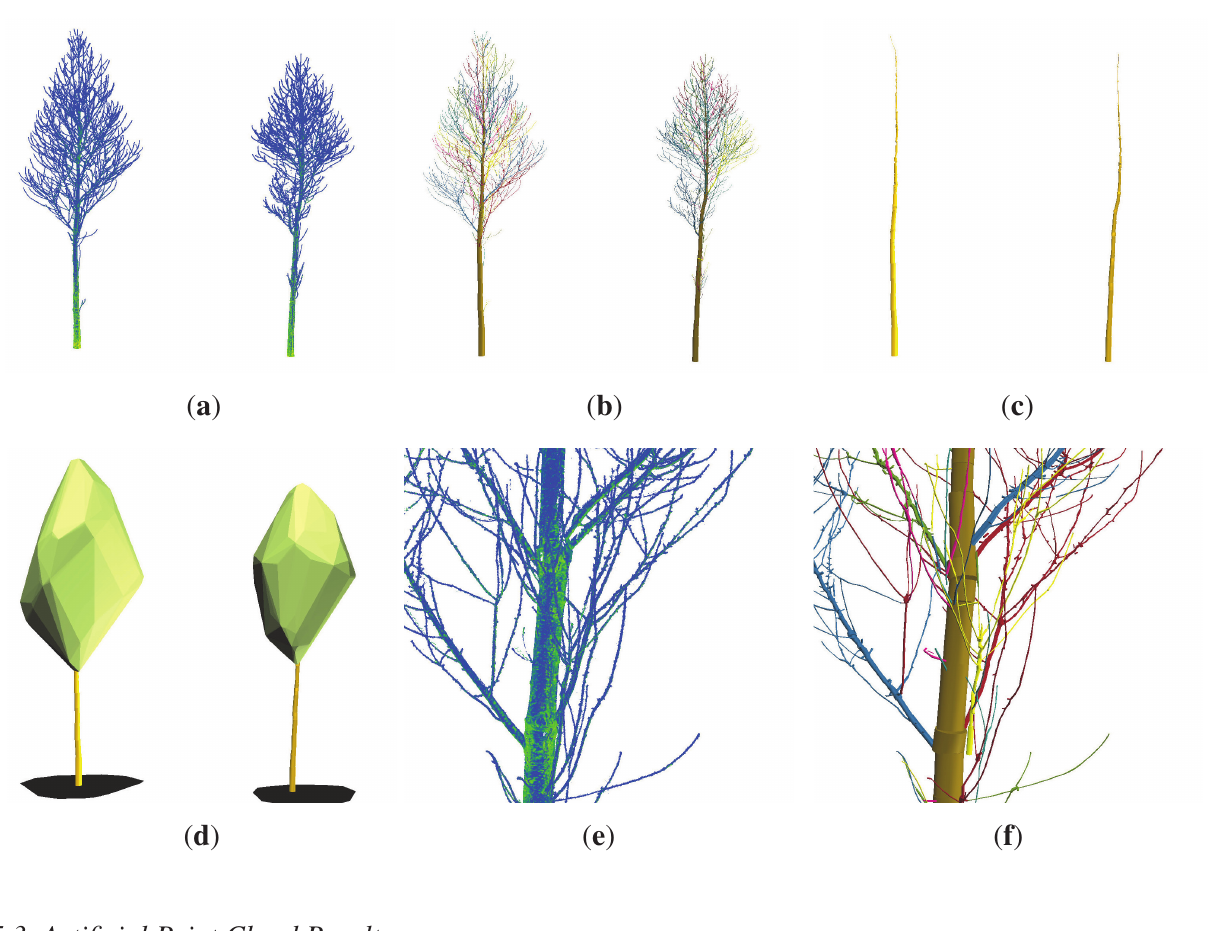
Figure 9. Visualization of both Group II trees (height ≈ 12 m): (a) TLS point clouds; (b) cylinder models with branches colored differently; (c) extracted stems of the cylinder models; (d) model of the crowns, stems and crown projections; (e) enlarged view into the lower crown point cloud of 2; (f) enlarged view into the lower crown cylinder model of